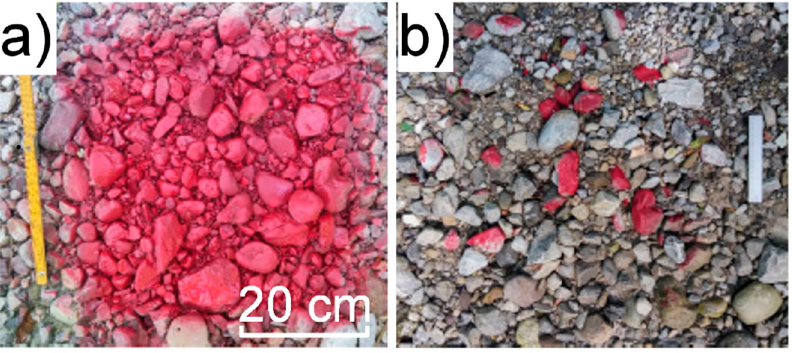
Figure 7. ( a ) A semi-Eulerian test area before (17 March) and ( b ) after (27 March) an event occurrence.